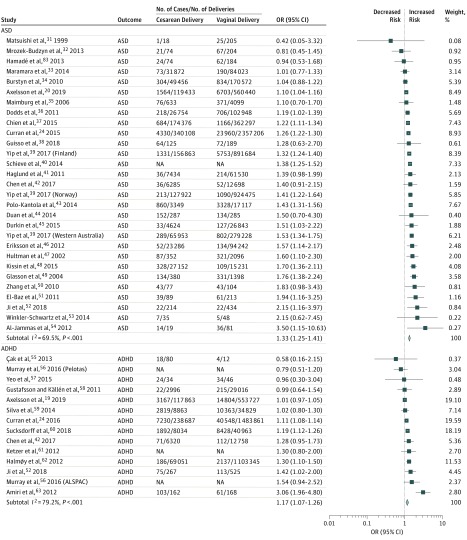
Forest Plot of the Results of Random-Effects Meta-analyses Stratified by Autism Spectrum Disorder (ASD) and Attention-Deficit/Hyperactivity Disorder (ADHD)Forest plot of odds ratios (ORs) in studies investigating the associations between cesarean delivery and each outcome. Diamonds show overall pooled estimate for each outcome. ALSPAC indicates Avon Longitudinal Study of Parents and Children; NA, not available.